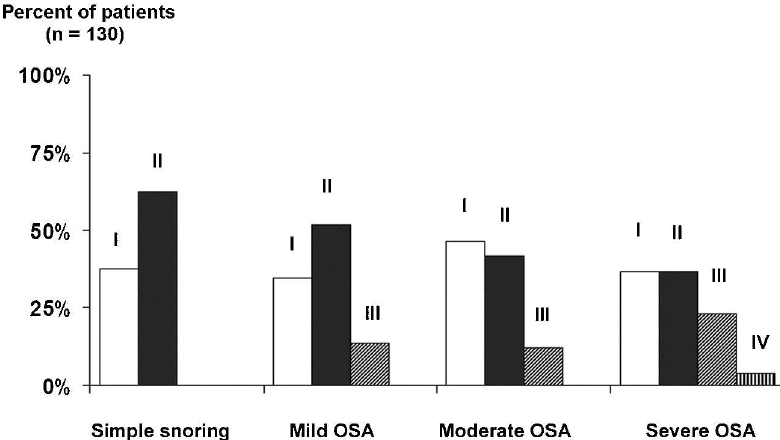
Figure 1 - Distribution of the observed tonsil grade (I, II, III or IV) among the various obstructive sleep apnea (OSA) severities ( p=